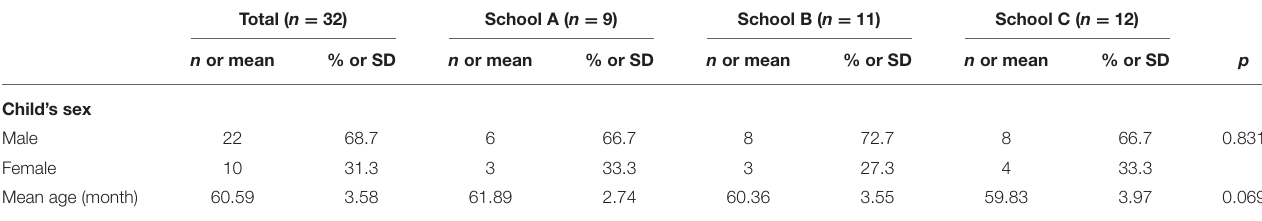
TABLE 1 | Characteristics of sample in this study ( n = 32).